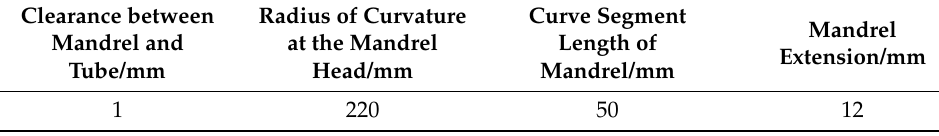
Table 3. Test parameter settings.